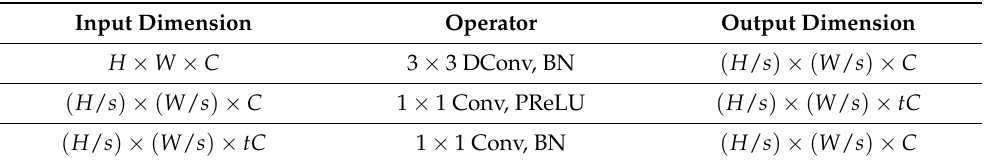
Table 1. The workflow of the ECN block. Here, ‘DConv’ denotes depthwise convolution, ‘Conv’ denotes convolution operation and ‘BN’ denotes batch